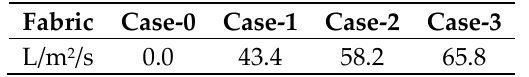
Figure 5. The flow around the elliptic cylinder, visualized using the smoke-wire method. Table 1. Fabric air permeability.